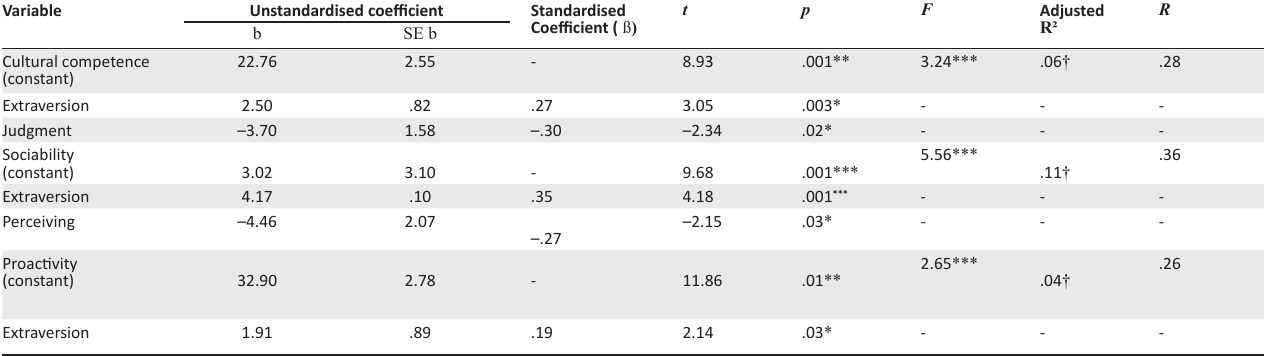
TABLE 5: Significant multiple regression results: Myers-Briggs Type Indicator and Employability Attributes Scale ( N = 304). Variable Unstandardised